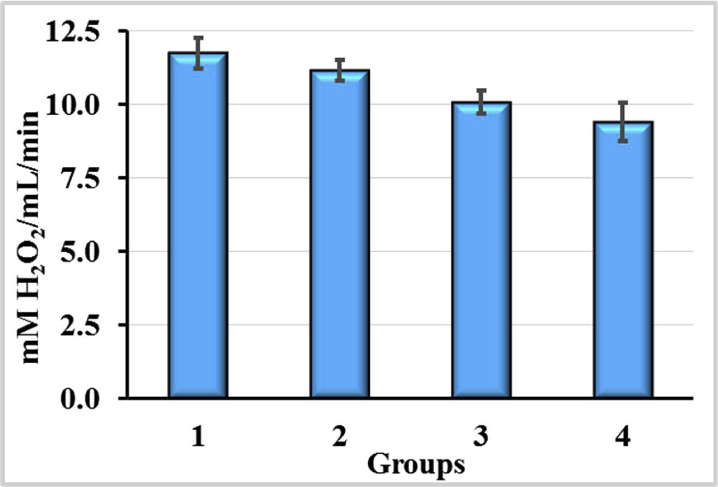
Catalase (CAT) activities in blood of rats exposured to CCl4 with or without enterosorption using AC1 and AC2 formulations, p < 0.05.